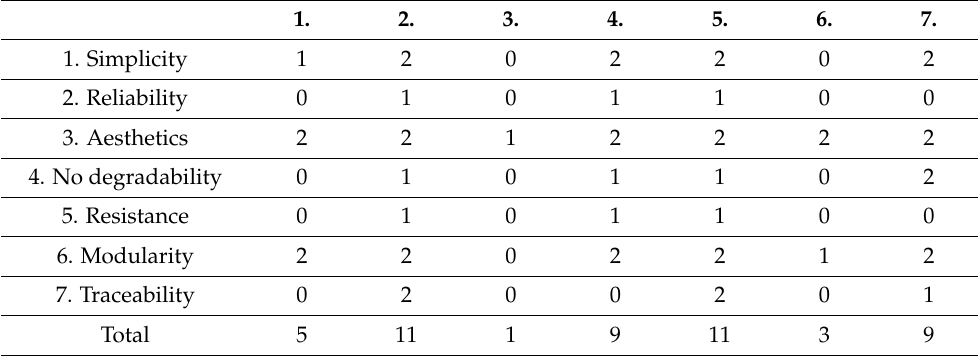
Table 2. Relative Importance Relationship